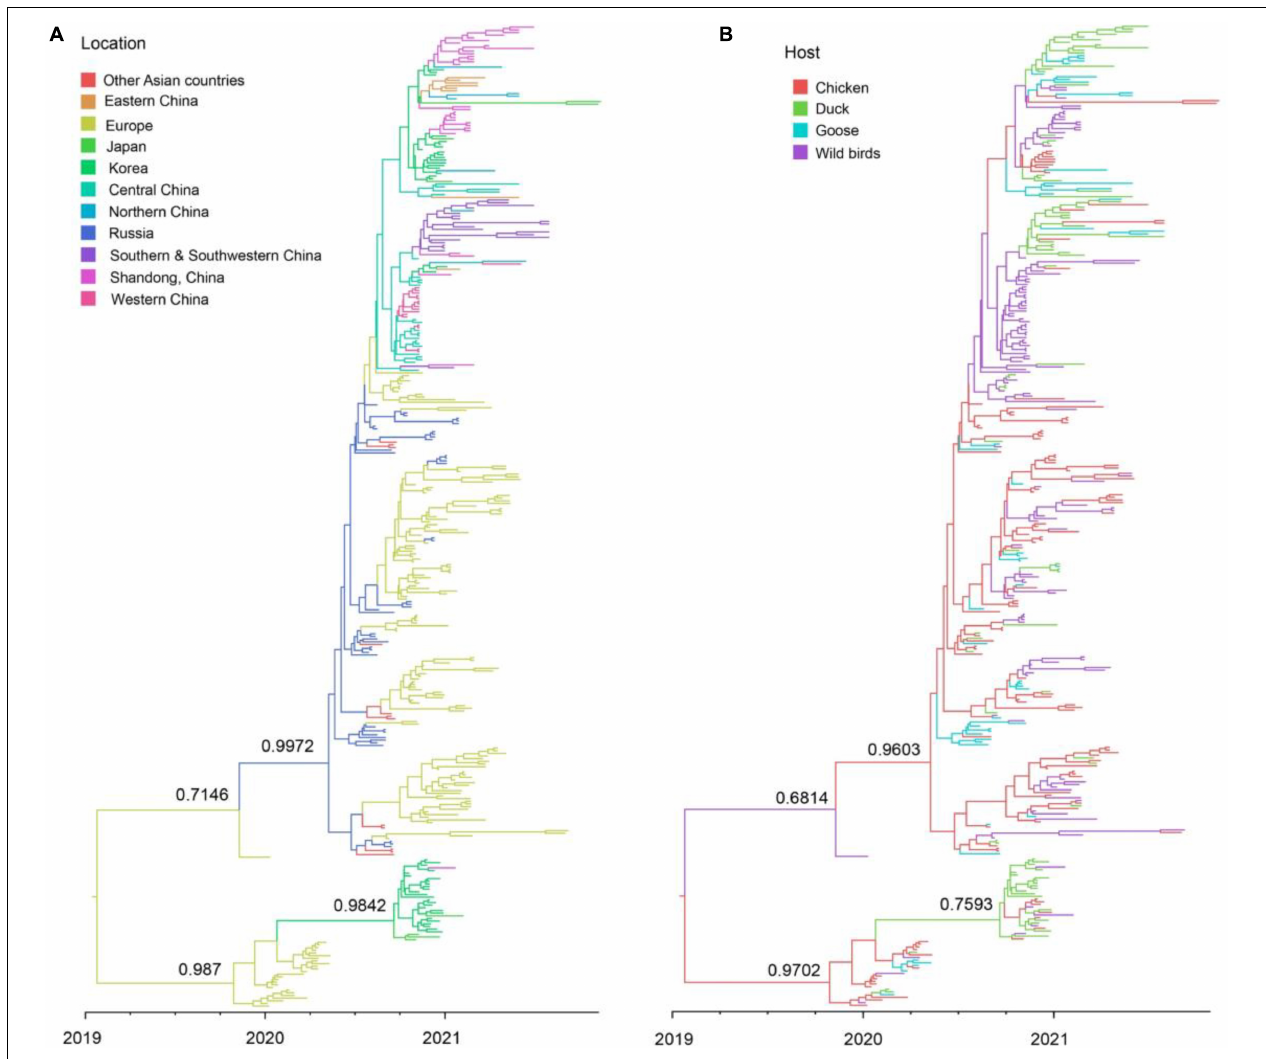
FIGURE 4 | Maximum clade credibility (MCC) time-scaled phylogenetic tree of HA sequences of clade 2.3.4.4b H5 subtype influenza viruses during 2020–2021 colored by geographic location (A) , and host species (B) . The branches are colored according to the most probable ancestral geographic location, and host type. The phylogenetic tree was visualized in the FigTree (version 1.4.3)